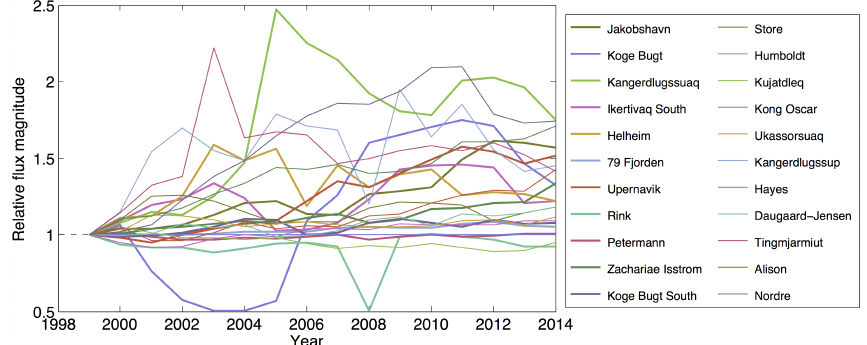
Figure 3. Time series of relative speedup applied to the modeled outlet glaciers marked in the right-hand panel of Fig. 1. Glaciers are ordered in the legend from greatest (Jakobshavn) to least (Nordre) flux in